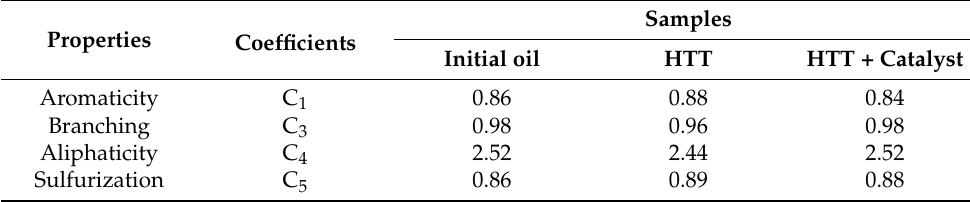
Figure 8. FT-IR spectroscopy of oil samples. Table 4. The FT-IR spectral coefficients of crude oil samples. Table 4. The FT-IR spectral coefficients of crude oil